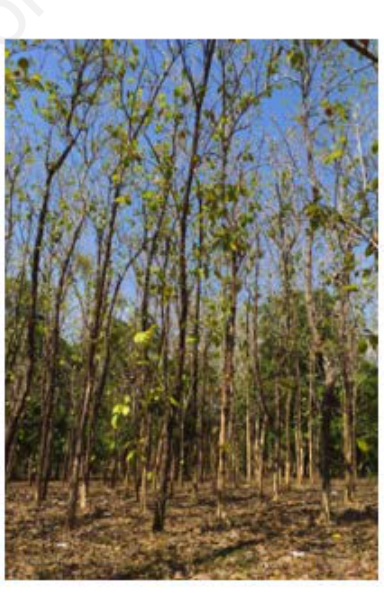
Figure 1. Teak Plantations in Makassar Campus of Hasanuddin University.